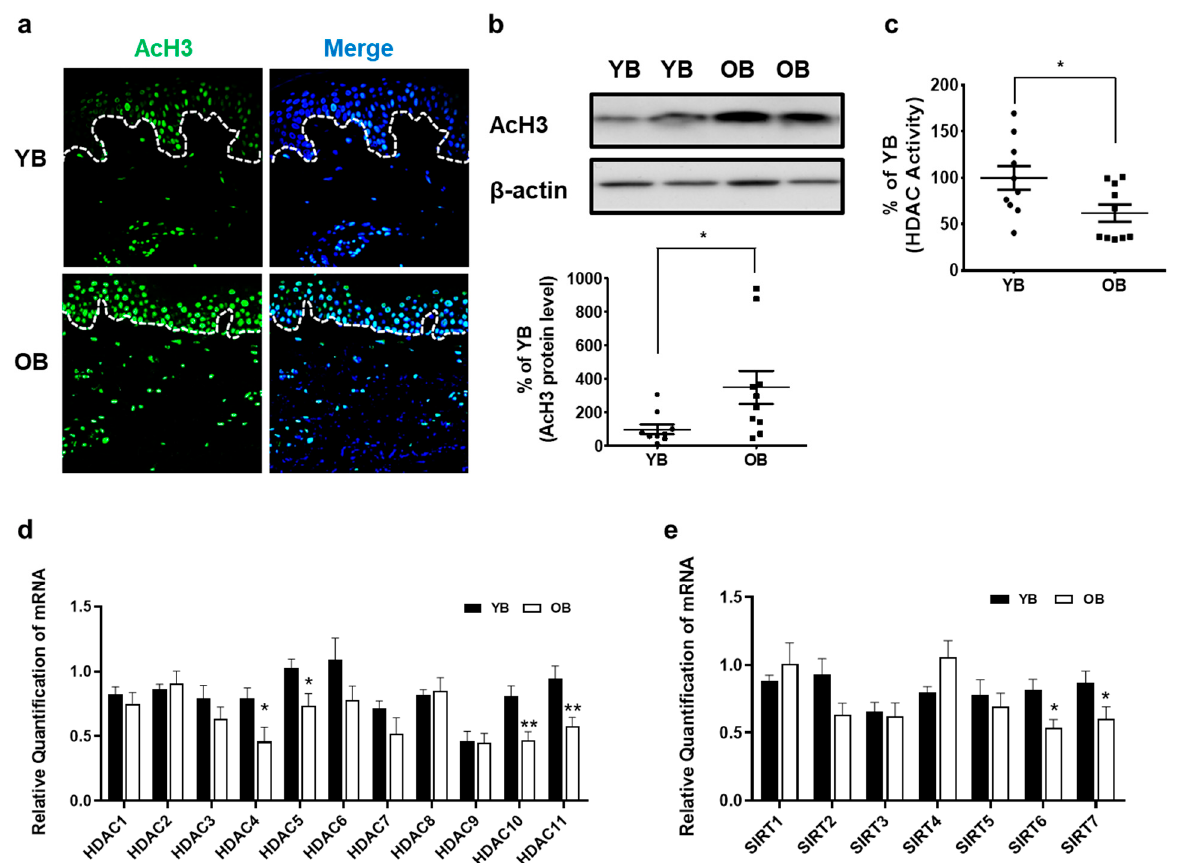
Figure 2. Acetylated histone H3 was increased, but HDAC activity and expression levels of HDAC4, HDAC5, HDAC10, HDAC11, SIRT6, and SIRT7 were decreased in intrinsically aged human skin in vivo. The buttock skin of young and elderly subjects was obtained by punch biopsy. Immunofluorescence analysis of AcH3 and DAPI staining of paraffin-embedded sections ( n = 6). Original magnification: ×200 ( a ). Western blot analysis of AcH3 and β -actin. The bands are representative of the results obtained for 10 young and 10 elderly subjects ( n = 10) ( b ). Total HDAC activity was measured using an HDAC assay kit ( n = 10) ( c ). Expression levels of HDAC and SIRT mRNAs were compared in young ( n = 10) and aged ( n = 10) subjects by qPCR ( d , e ). Data were normalized to one of the young subjects. Data are presented as means ± SEM. Statistical significances were determined using a two-tailed Student’s t -test. * p < 0.05, ** p < 0.01 vs. YB. YB: young buttock skin; OB: old buttock skin.